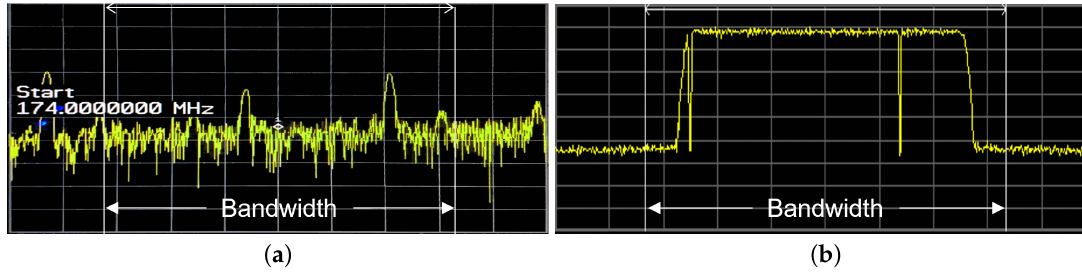
Figure 8. Frequency response in ( a ) the Finite Impulse Response (FIR) filter by the compiler and ( b ) the designed FIR filter both with 150 MHz clock. Bandwidth = 1.536 MHz.